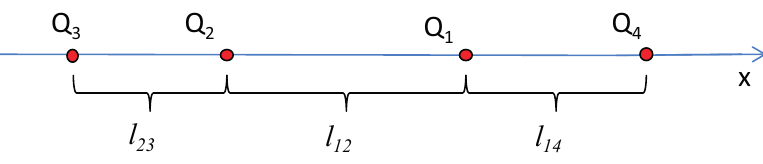
Figure A2. One-dimensional presentation of the system.